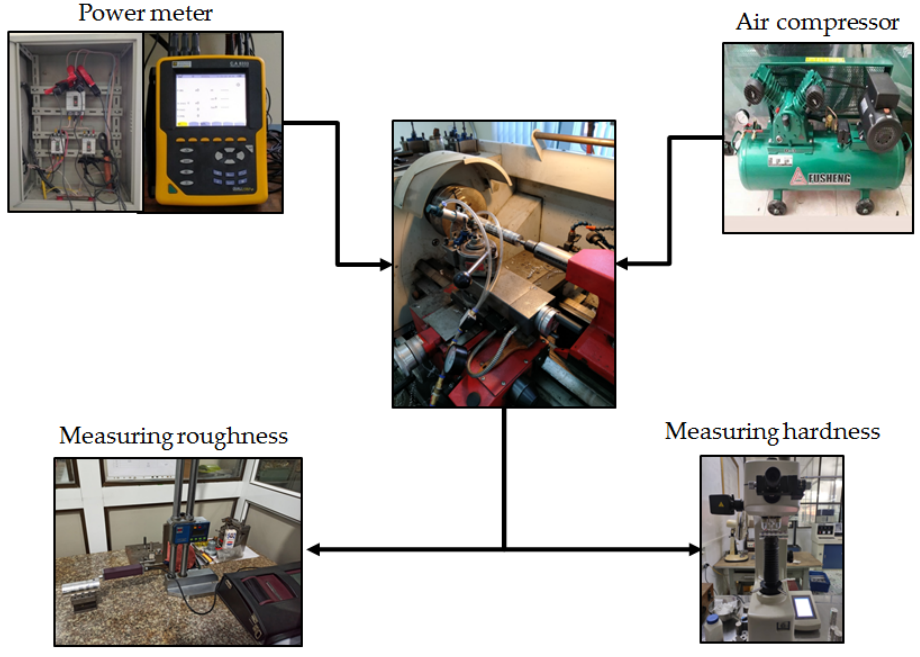
Figure 3. Experiments and measurements.